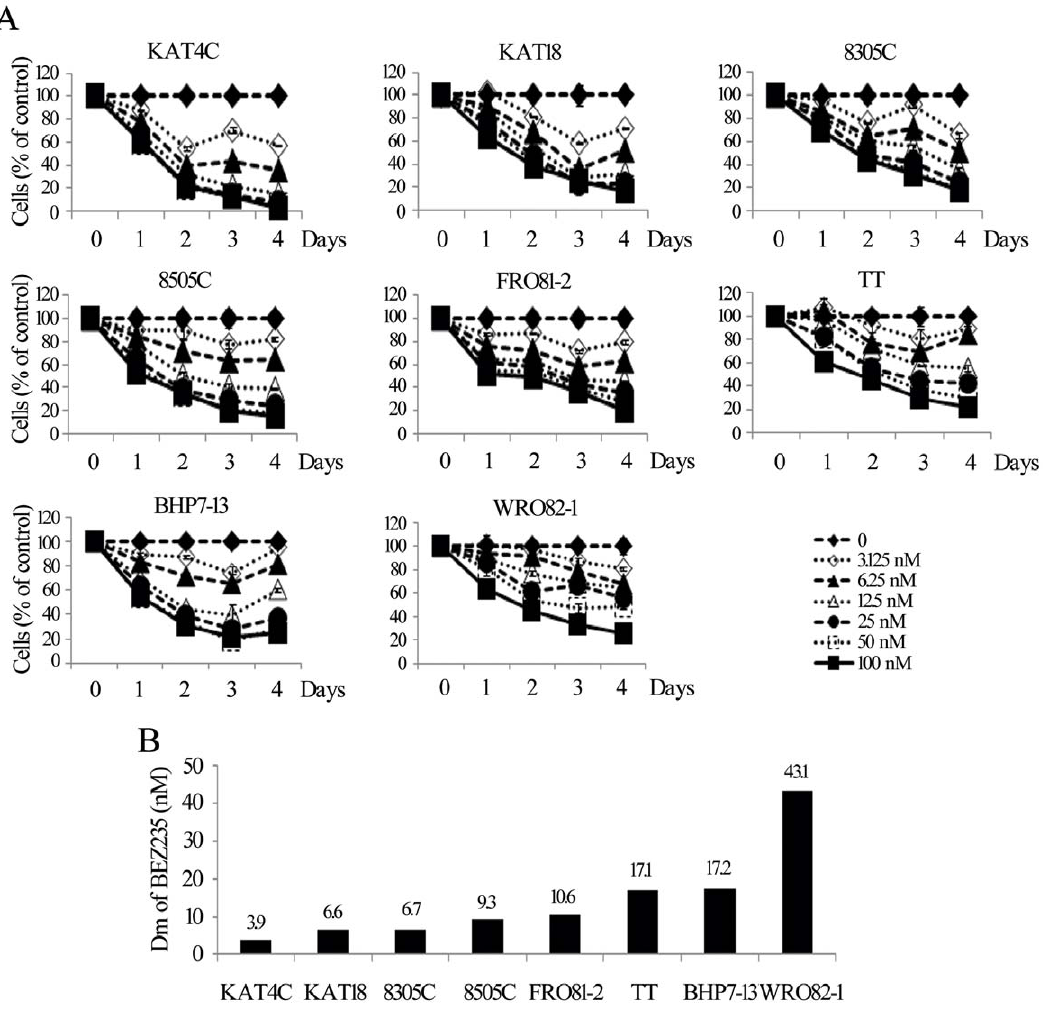
Figure 1. BEZ235 induces dose and time dependent cytotoxicity in 8 thyroid cancer cell lines. A, dose-response curves were obtained daily from cells treated with a range of six 1:1 dilutions of BEZ235. B, the Dm of BEZ235 on day 4 was calculated using CompuSyn software for each cell line. ATC cell lines (KAT4C, KAT18, 8305C and 8505C) had the lowest Dm and thus most sensitive, follow by follicular undifferentiated thyroid cancer (FRO81-2), medullary (TT) and well-differentiated papillary (BHP7-13) and follicular (WRO82-1)